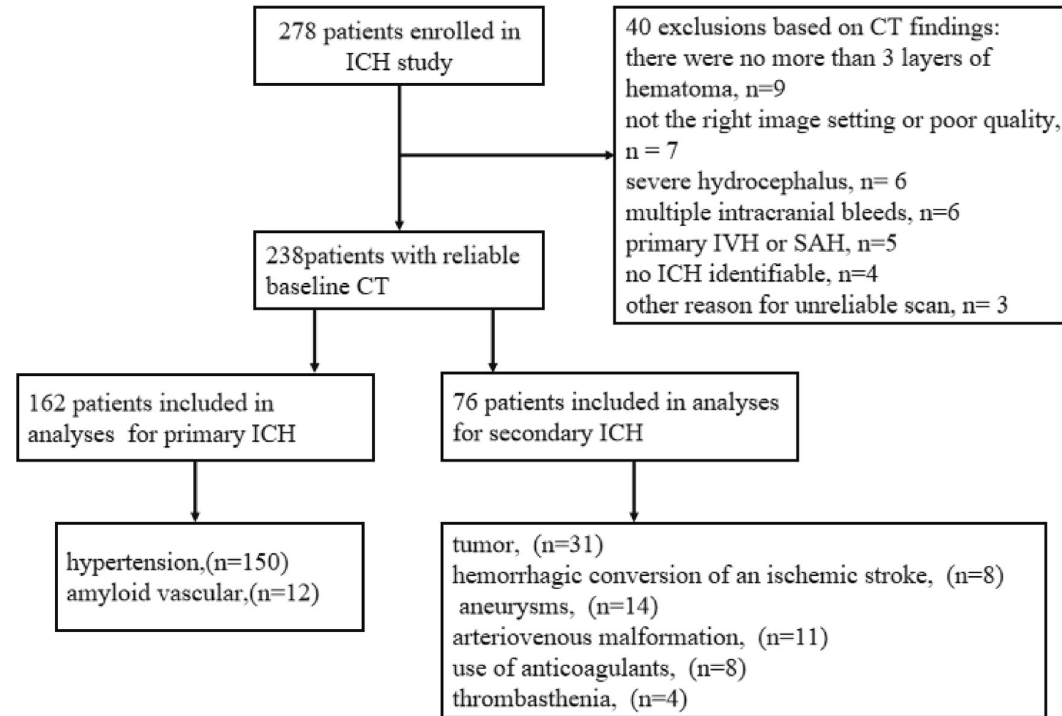
Figure 1. Patient inclusion/exclusion